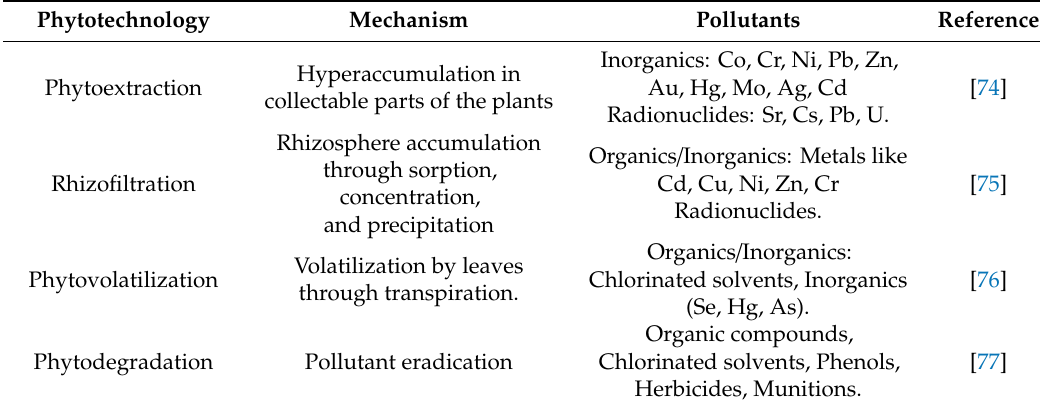
Table 2. Phytoremediation processes.